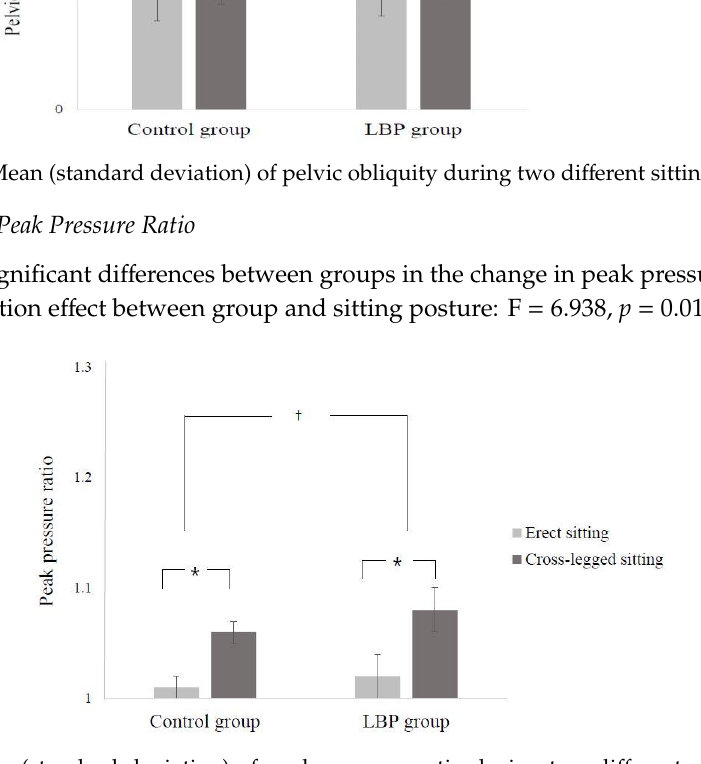
Figure 4. Mean (standard deviation) of peak pressure ratio during two different sitting postures. * Significantly different within the group. † Significantly different between groups.